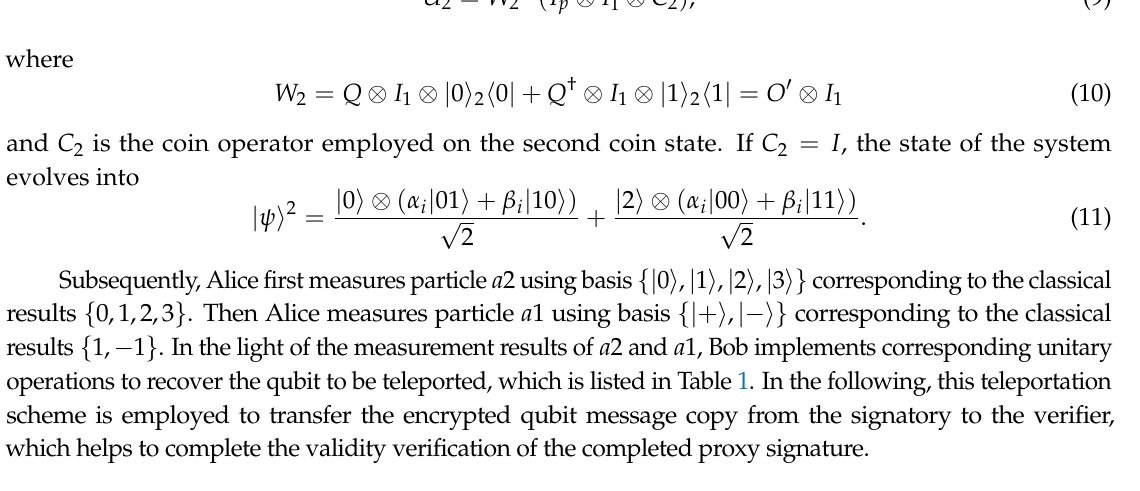
Table 1. The relationship of the measurement results of a 2 and a 1 from Alice and Bob’s local unitary